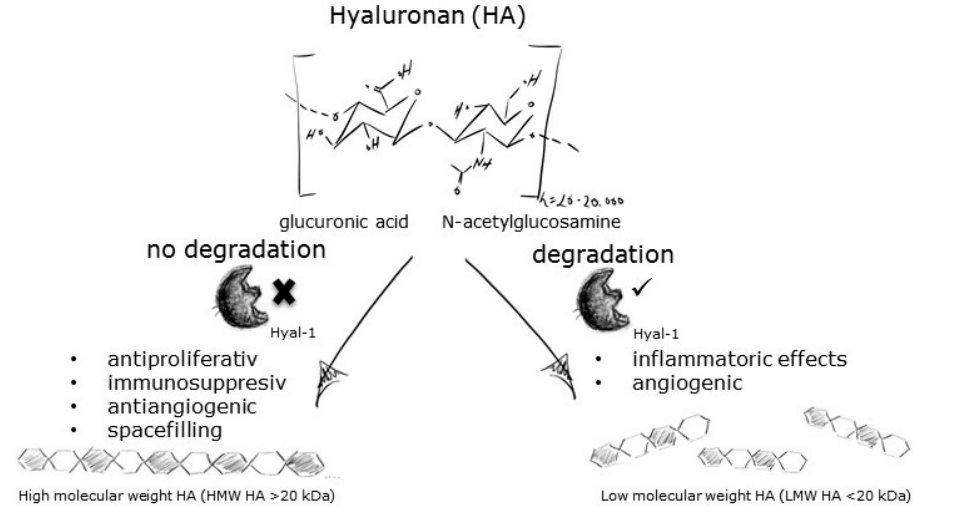
Figure 1. Physiological and pathophysiological functions of hyaluronan.